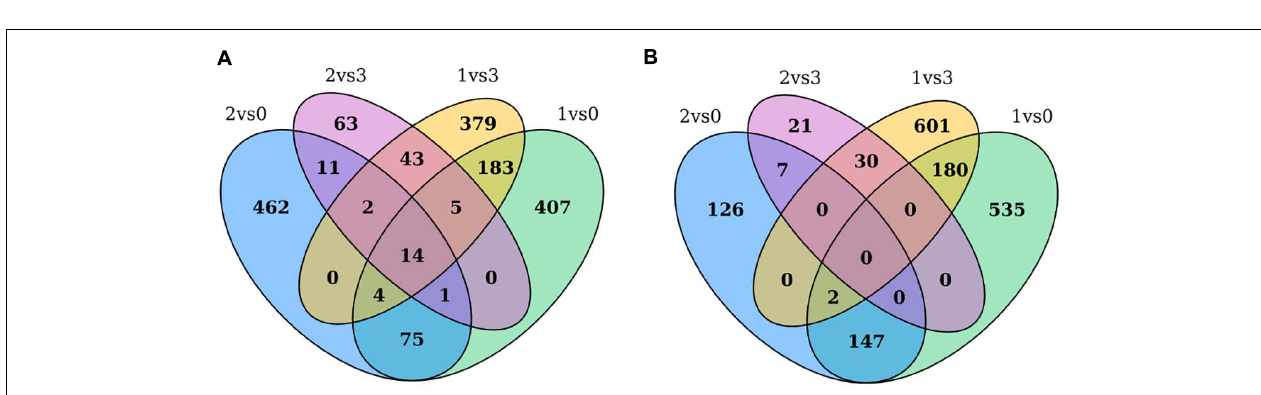
FIGURE 6 | Functional analysis of VfSOC1 . (A) Expression pattern of VfSOC1 in stem, root, leaf and flower in faba bean. (B) Time-course of expression of VfSOC1 in leaf after vernalization, (C) Semi-quantitative expression analysis VfSOC1 in three independent overexpression lines. The Arabidopsis Actin gene was amplified as a control. (D) Overexpression of VfSOC1 in wild-type (Col-0) promote flowering. All plants are planted under long days.